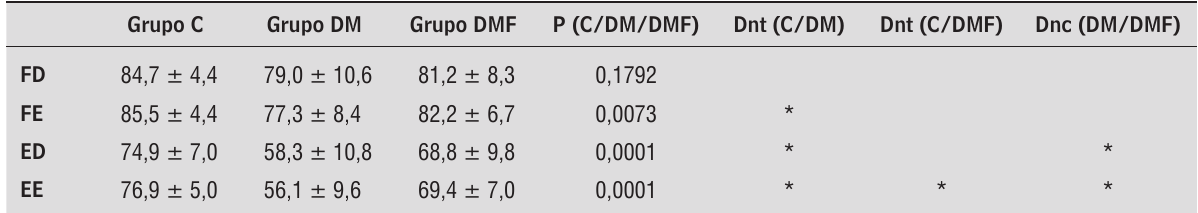
Tabela 1 - Dados demográficos da população em estudo